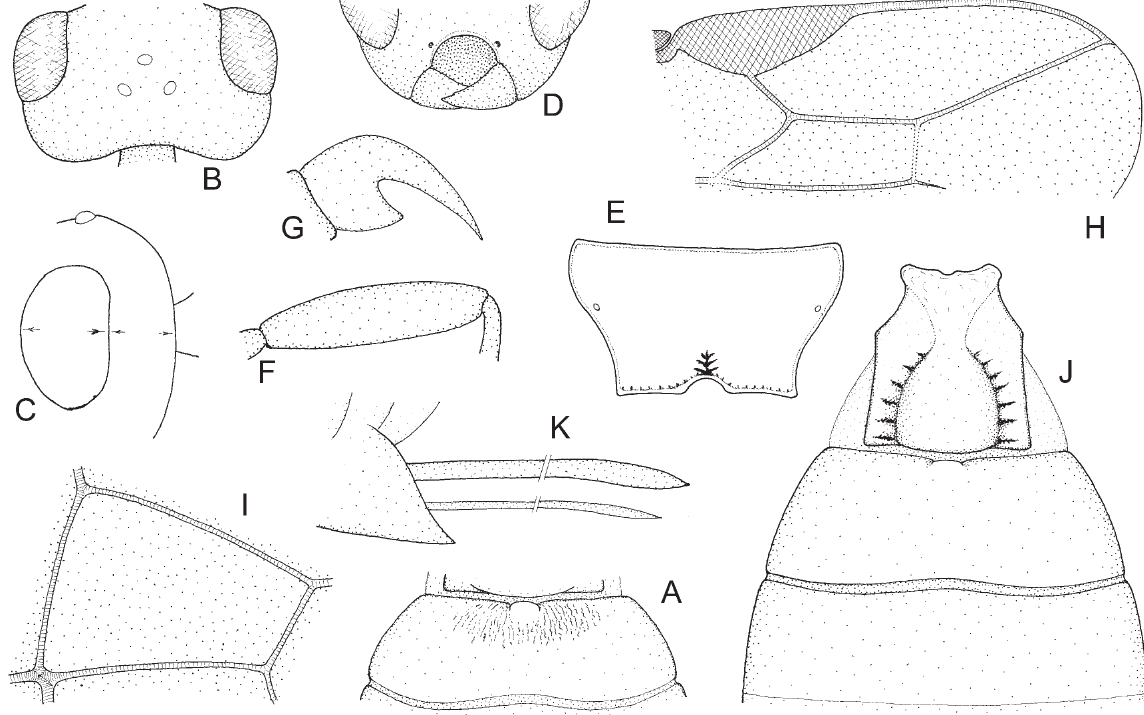
Fig. 5. — A . Bracon ( Glabrobracon ) dichromus Wesmael, 1838, ♀, second tergite. — B-K . Bracon ( Glabrobracon ) discoideus Wesmael, 1838, ♀ lectotype. B . Head in dorsal view. C . Head in lateral view. D . Head in frontal view. E . Propodeum. F . Hind femur. G . Claw. H . Distal part of right